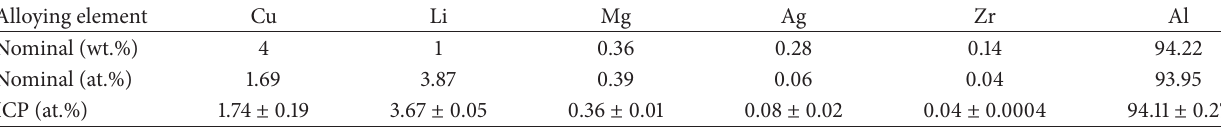
Table 1: Chemical composition of alloying elements in